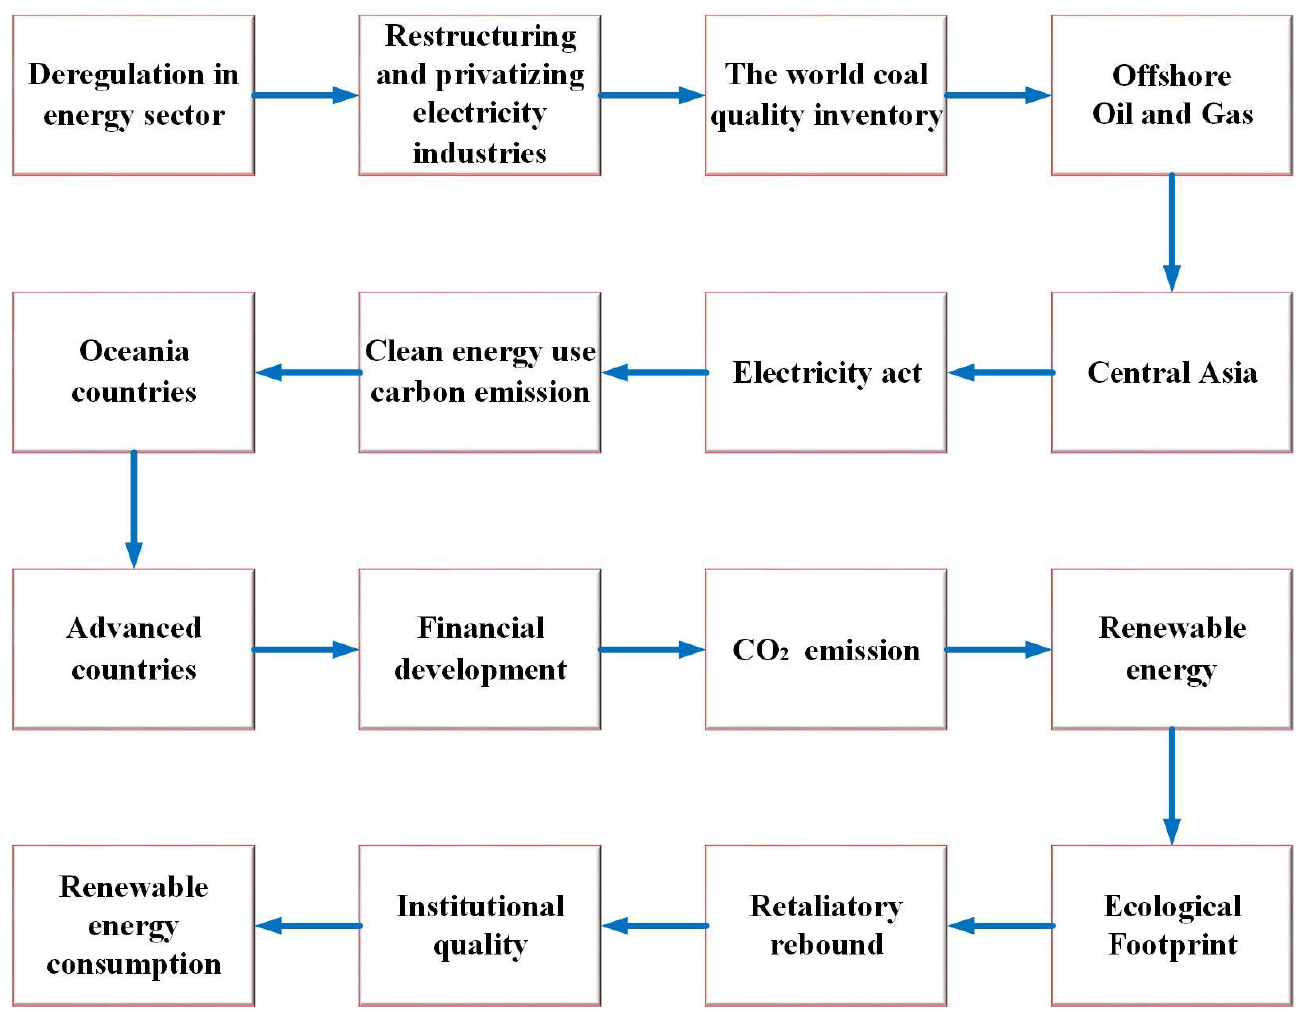
Figure 10. Co-Citation cluster evolution path.